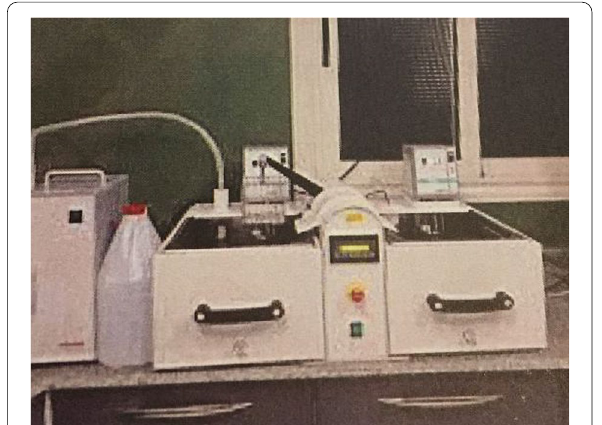
Fig. 6 Graph showing shear bond strength values in